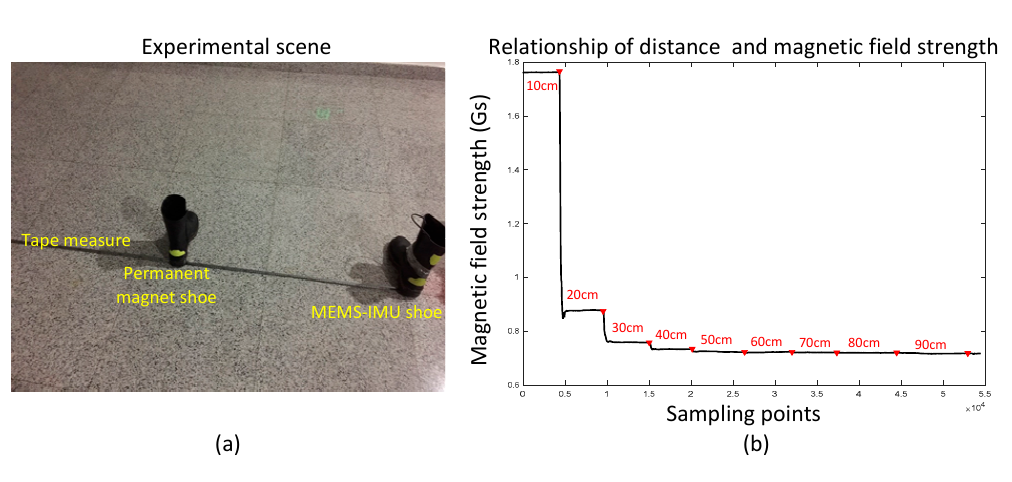
Figure 6. Relationship of distance and magnetic field strength; ( a ) is a picture of the experiment scene. The left shoe is mounted with a MEMS-IMU and the right shoe is mounted with a permanent magnet. The right shoe moves along the ruler and stops every 10 cm; ( b ) is the result of the relationship between distance and magnetic field strength.